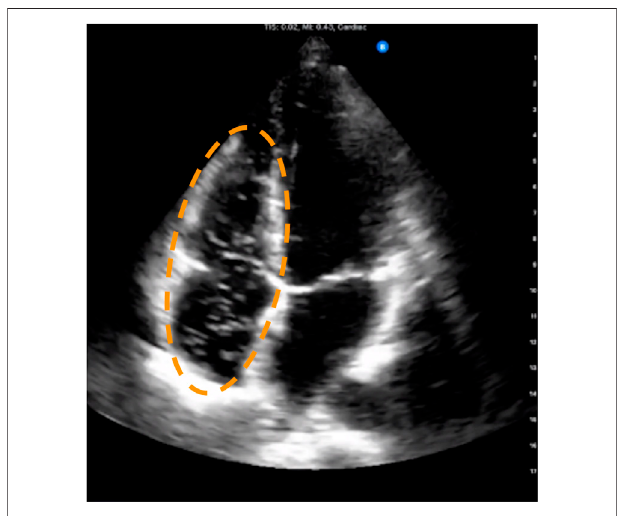
FIGURE 1 | Example frame from four-chamber trans-thoracic echocardiography showing venous gas emboli circulating in the right atrium and ventricle. These appear as bright spots against the dark background that istheblood inside thechambers.Thedashed ellipse outlinesthevenous chambers where venous gas emboli are typically seen when